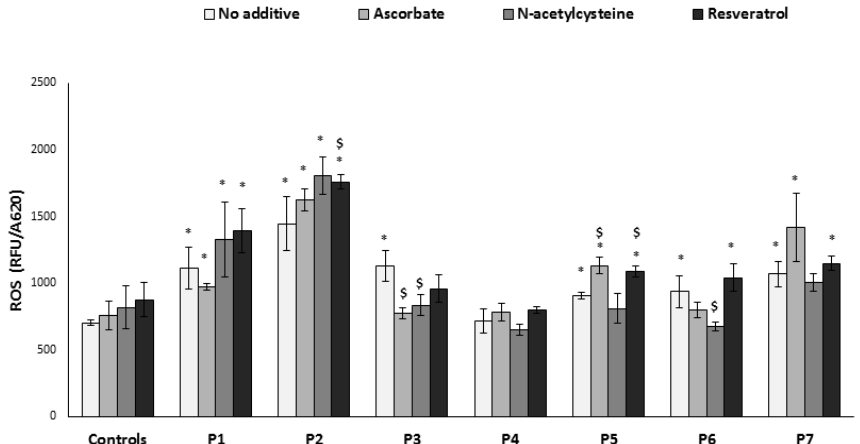
Figure 1. Reactive oxygen species (ROS) production. Fibroblasts in microtiter wells were incubated in the absence or presence of the compounds for 72 h, ROS production (relative fluorescence units, RFU) was determined and normalized to cell content (A620). Results are presented as mean ± SEM of triplicate wells of at least two independent experiments. * p < 0.05 compared to mean of 3 controls in the corresponding medium, $ p < 0.05 compared to individual patient cells without additive.